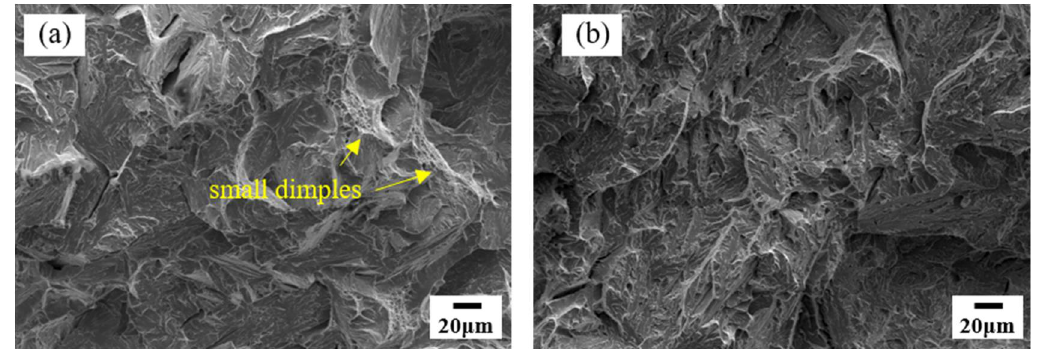
Figure 10. SEM micrographs of fracture surfaces of the simulated sample with peak temperature of ( a ) 1150 °C and ( b ) 1350 °C.